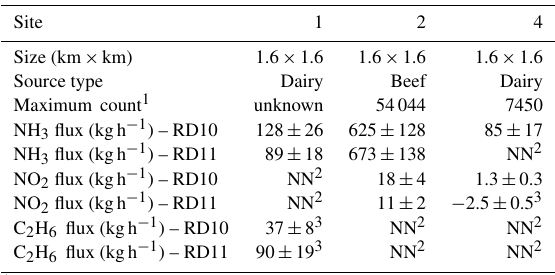
Table 5. NH 3 , NO 2 and C 2 H 6 flux estimates from 12 August (RD10) and the case study on 13 August 2014 (RD11). The uncer- tainty on the fluxes is assuming the model wind has an uncertainty of 20%.